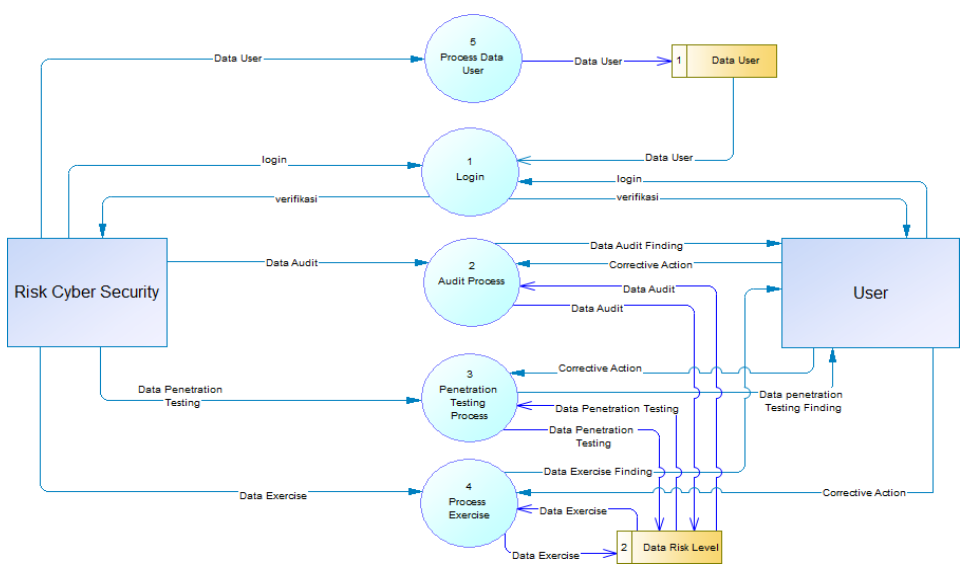
Figure 9. Data Flow Diagram of the Level 1 Testing Using Audit, Exercise and Penetration Testing.